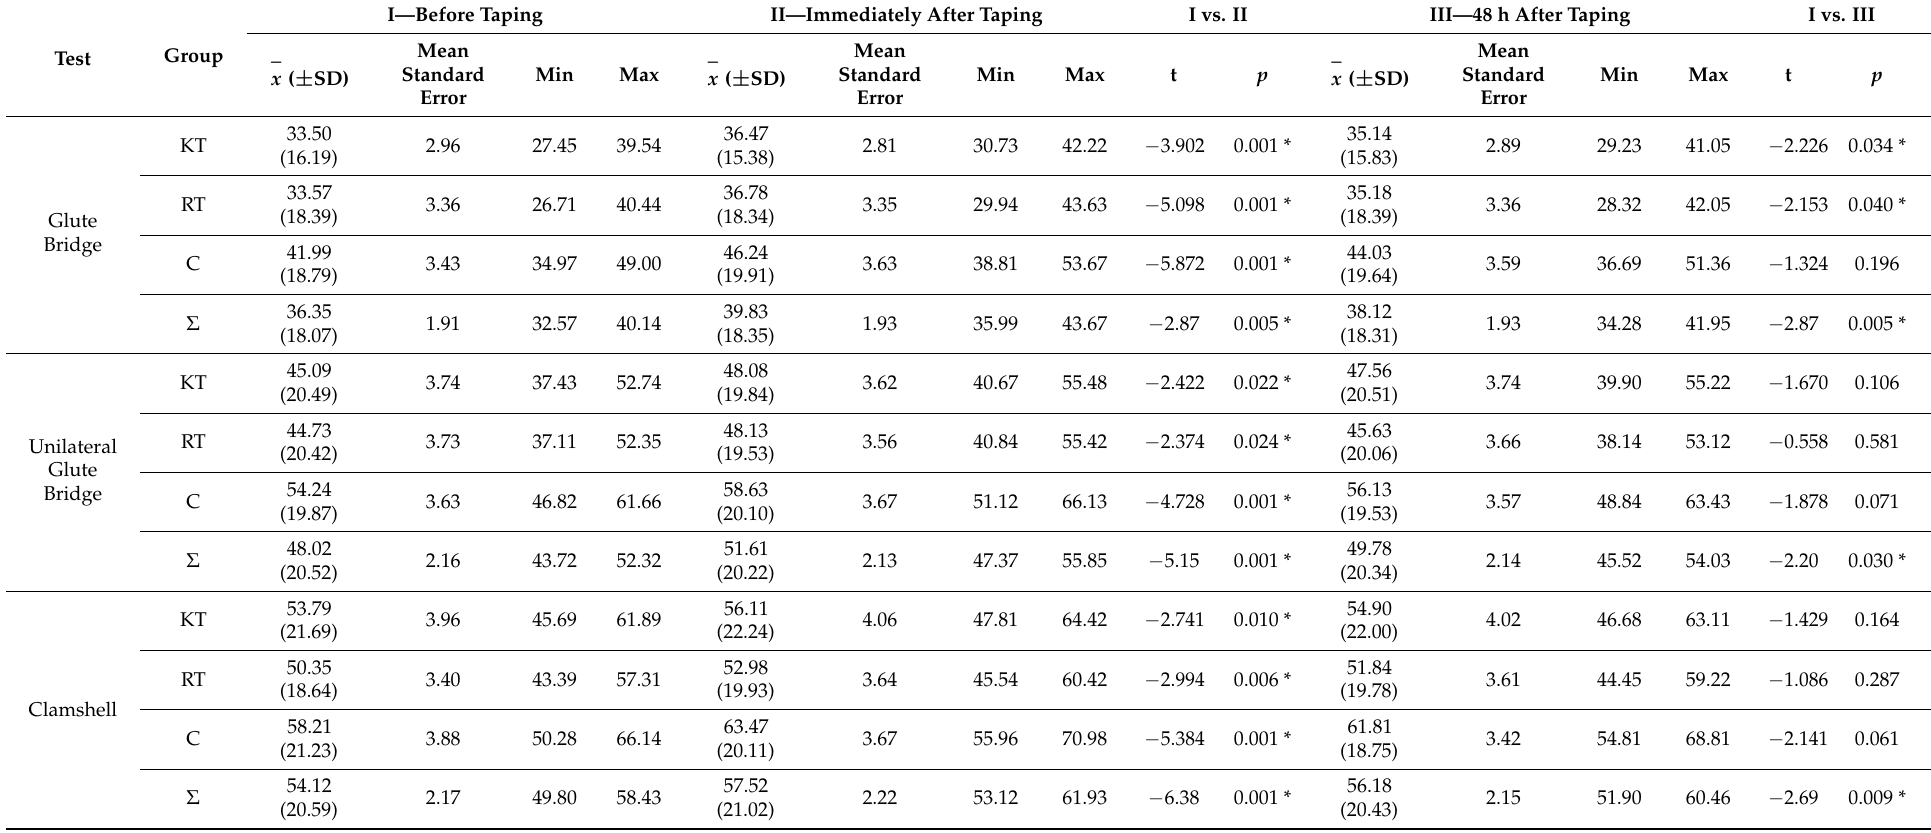
Table 4. Comparison of results (%MVIC) in the exercises performed at particular stages of examination (N =